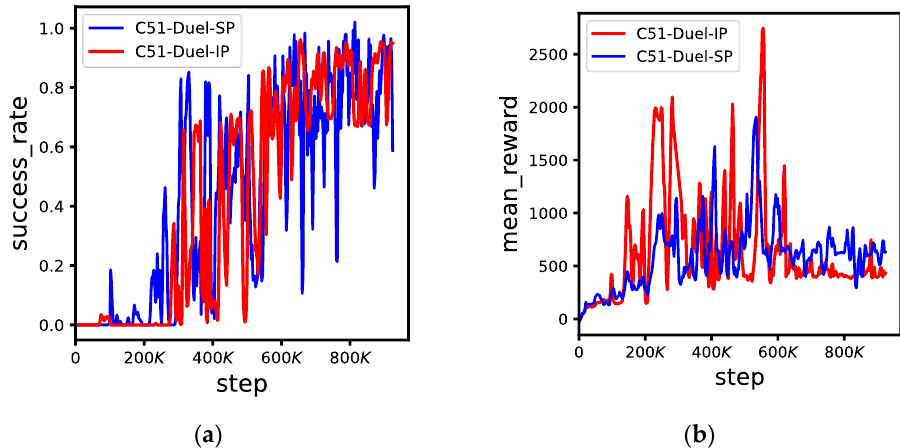
Figure 8. Comparison of independent policies and shared policies in scenario 2: ( a ) shows the suc- cess rate; ( b ) shows the mean reward in each episode.